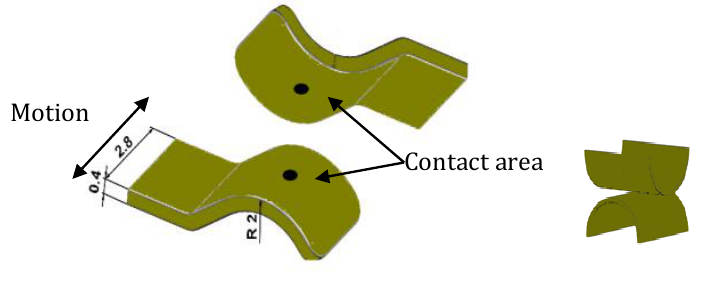
Figure 12. Sample size A, radius of contact cylinder R = 2.0 mm.